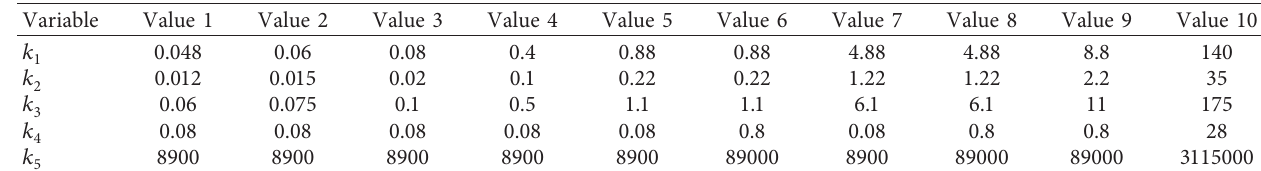
Figure 4: Desired trajectory of the HST. Table 2: Designed parameter variables for